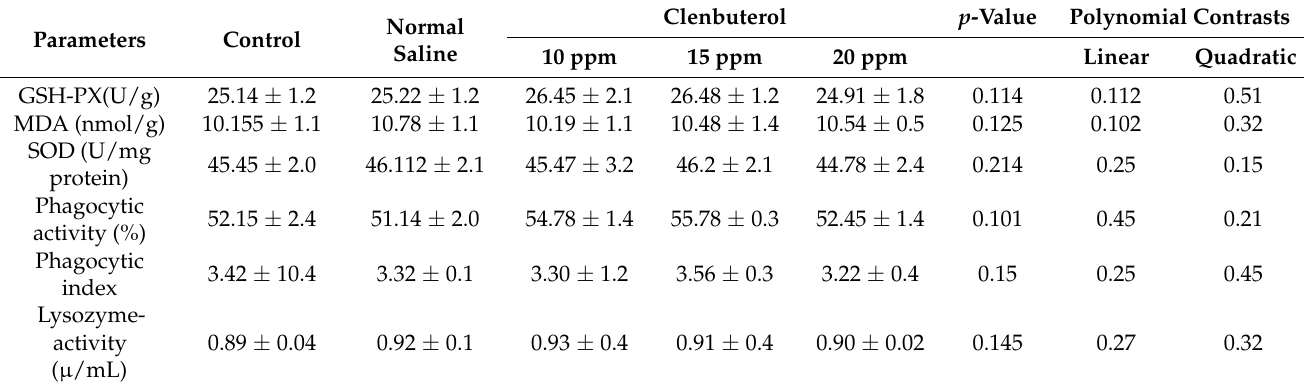
Table 5. Effect of in ovo feeding of clenbuterol on the antioxidants and immunological markers pattern. Parameters